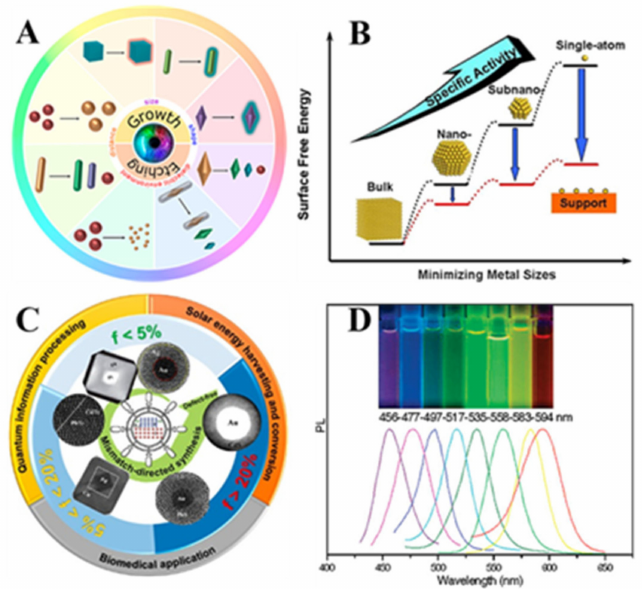
Figure 3. Various nanocrystalline materials. ( A ) Various shapes of noble metal NCs [40]. Copyright 2019 American Chemical Society. ( B ) Subnano- to single-atom catalysts [48]. Copyright 2013